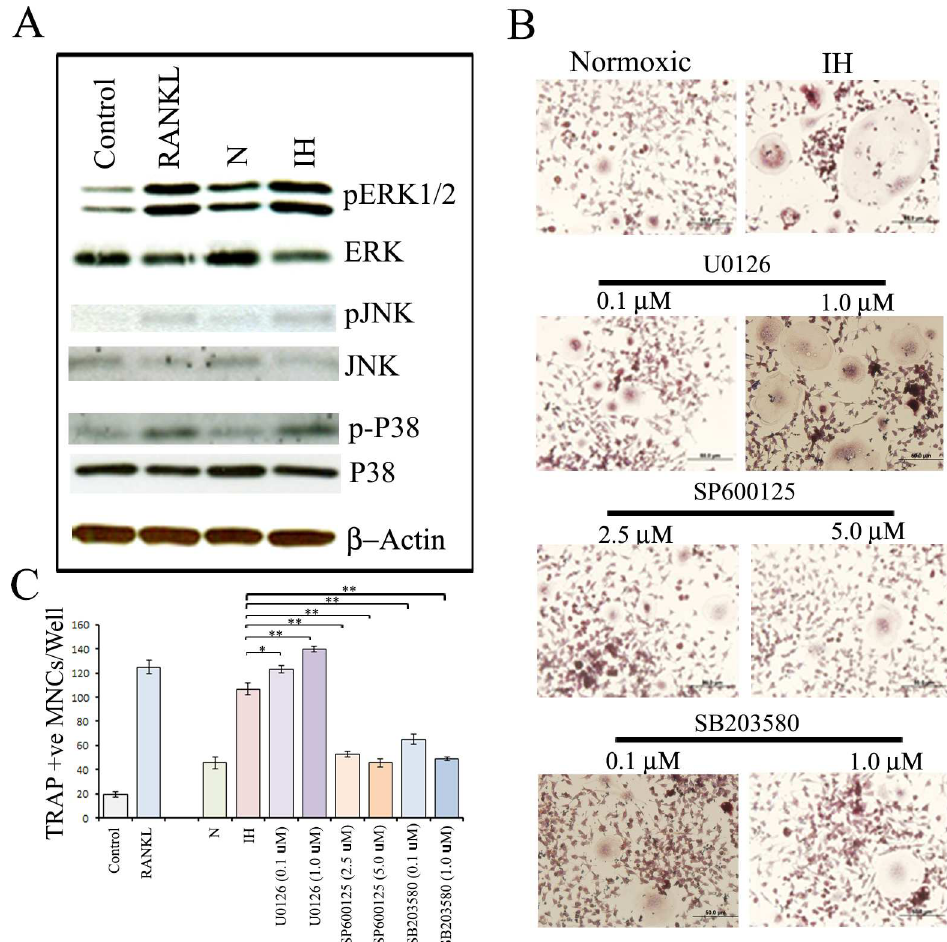
Fig 4. Effects of intermittent hypoxia exposure to neuroblastoma cells on modulation of osteoclastogenic signaling pathways in RAW 264.7 cells. (A) RAW 264.7 cells wereexposedto growth medium(control), growth mediumwith RANKL(100 η g/ml), CM from parentalSH-SY5Y cells, or intermittent hypoxia-exposed(IH) cells. The cells were then allowedto grow for six days undernormoxiawith medium changeafter three days. The JNK, ERK and p38 activationstates weredetermined by immunoblot analysis usingantibodies specifically directedagainst the phosphorylated forms of the enzymes, comparedto data obtainedwith antibodiesdirectedagainstthe unphosphorylatedstates of the kinases.(B) RAW 264.7 cells wereexposedto CM from parentalSH-SY5Y cells(N), IH cells or IH cells treatedwith 0.1 or 1 μ M U0126 (MEK signalingpathwayinhibitor),2.5 or 5 μ M SP600125(JNK signalingpathwayinhibitor)and 0.1 or 1 μ M SB203580(p38 signalingpathway) and culturedundernormoxia.The medium was changedafter three days. After six days, cultures wereanalyzedfor TRAP-positive multinucleated cells containingthree or more nuclei undera light microscope. A representative imageis shown.(C) Graphical representationof the number of TRAP-positive multinucleated cells. Values represent the number of TRAP positivecells countedin ten differentfields for each experimentfrom three independentexperiments and expressed as mean ± SD. * P < 0.05, ** P < 0.01IH versus IH treated with SP600125(2.5 or 5 μ M) or SB203580(0.1 or 1 μ